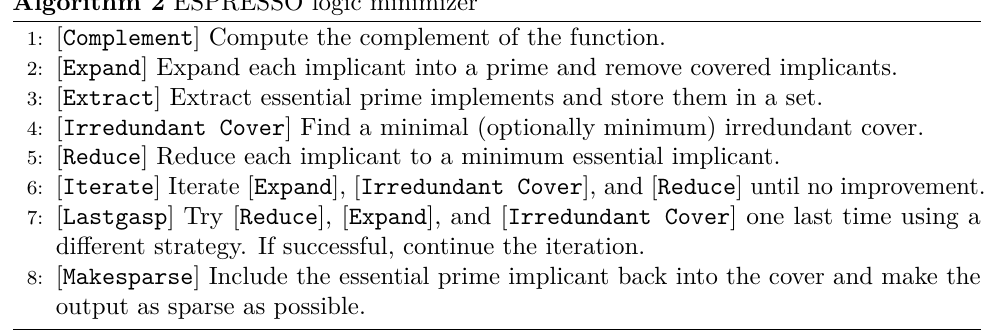
Algorithm 2 ESPRESSO logic